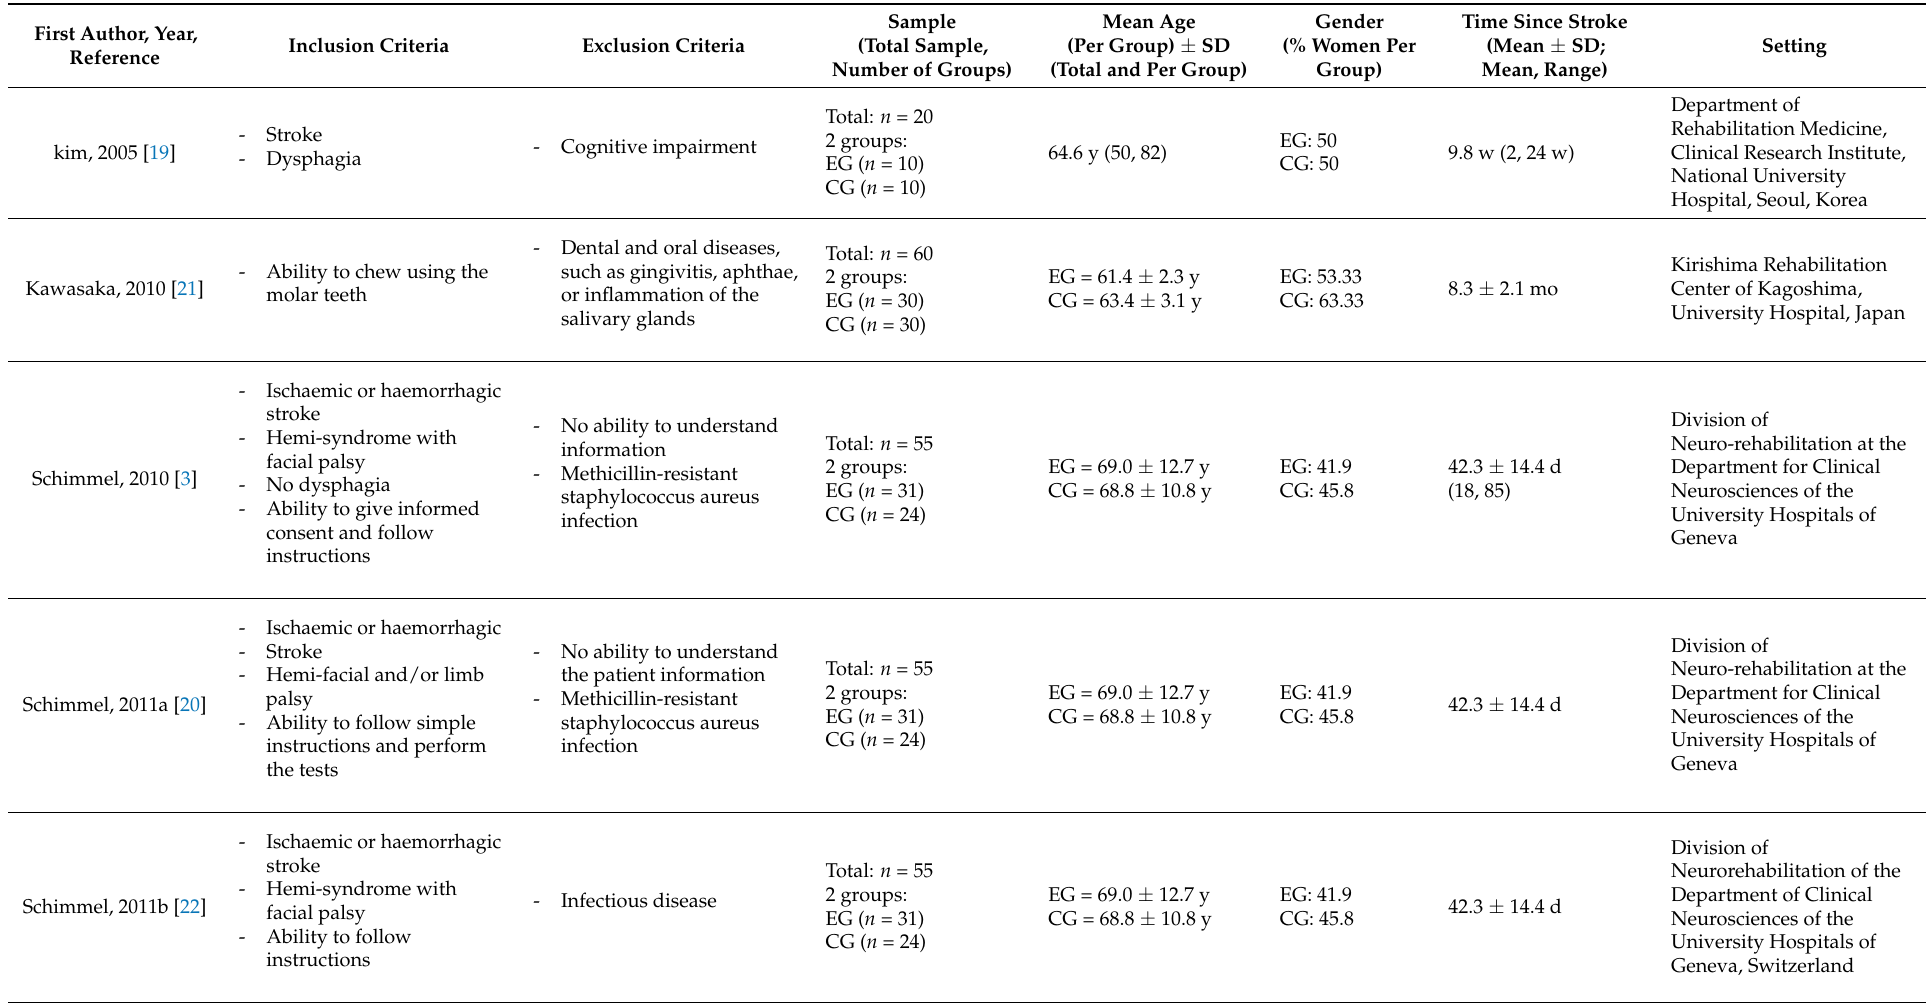
Table 1. Characteristics of the studies included in the systematic